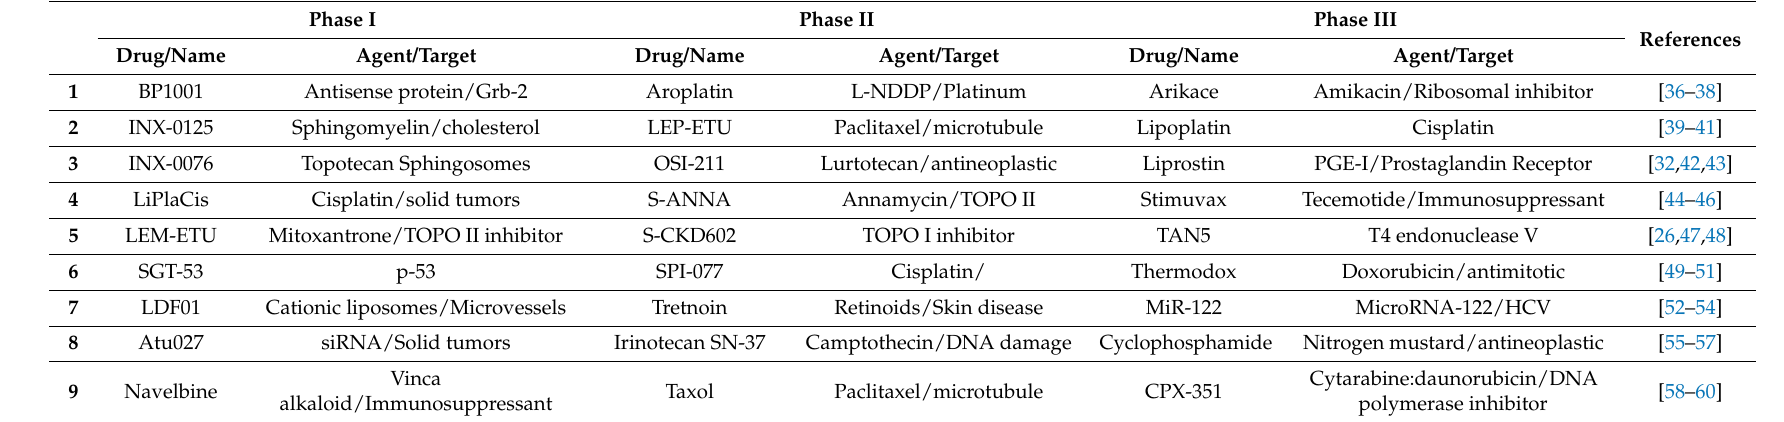
Table 1. Liposomes under different phases of clinical